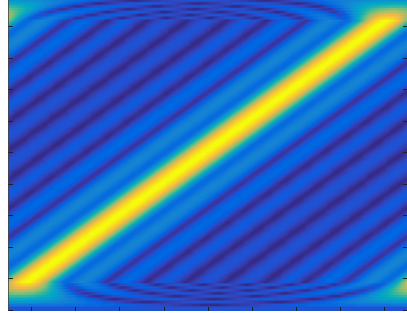
Figure 2. The transmit beampattern at R = 3 km in CSTCA.